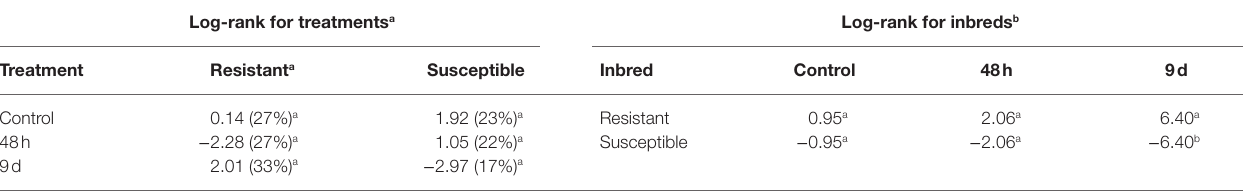
TABLE 1 | MCB larval survival on non-choice feeding bioassay. Log-rank for treatments